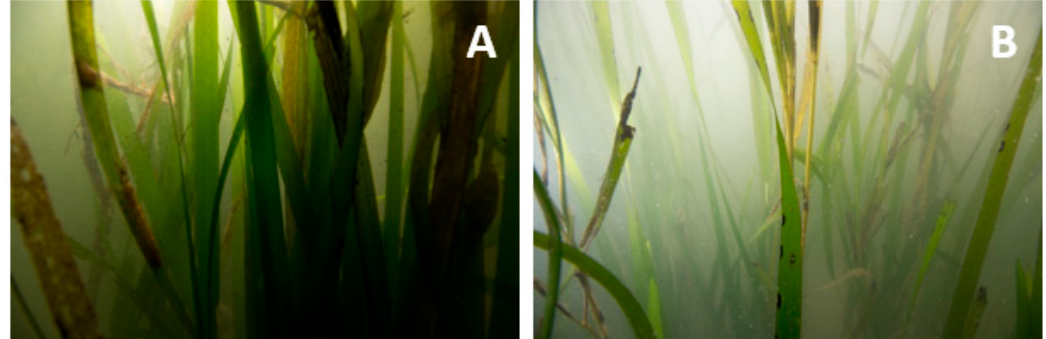
Figure 13. Photographs taken of eelgrass in Elkhorn Slough showing the eelgrass canopy in the turbid water. This illustrates how a single benthic reflectance corresponding to a green leaf is not a good proxy for the three-dimensional architecture and variability of shoots within the canopy. Photo credit Eric Heupel.